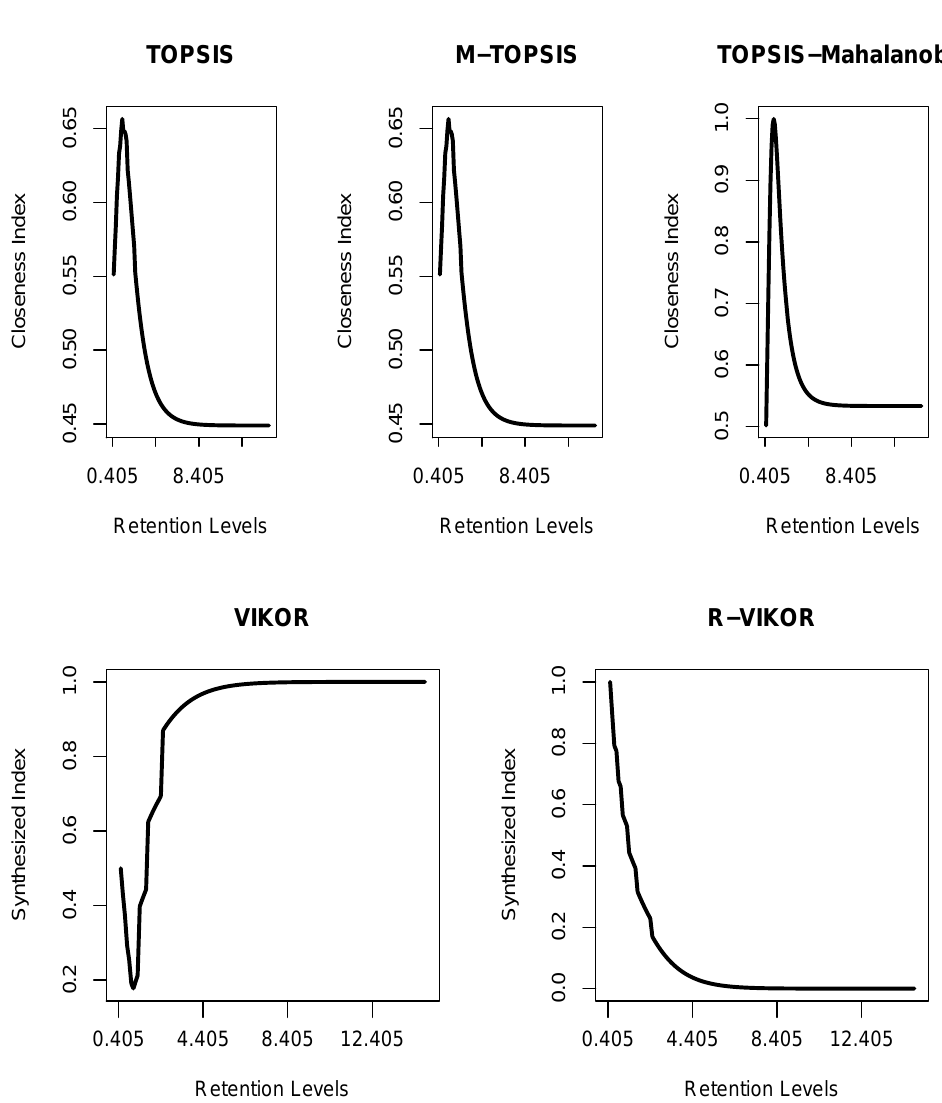
Figure 1. Comparison of rankings under the expected value premium principle when u = 5 and t = 1. TOPSIS: Technique for Order of Preference by Similarity to Ideal Solution; M-TOPSIS: Modified TOPSIS; VIKOR: VIseKriterijumska Optimizacija I Kompromisno Resenje; R-VIKOR: Revised